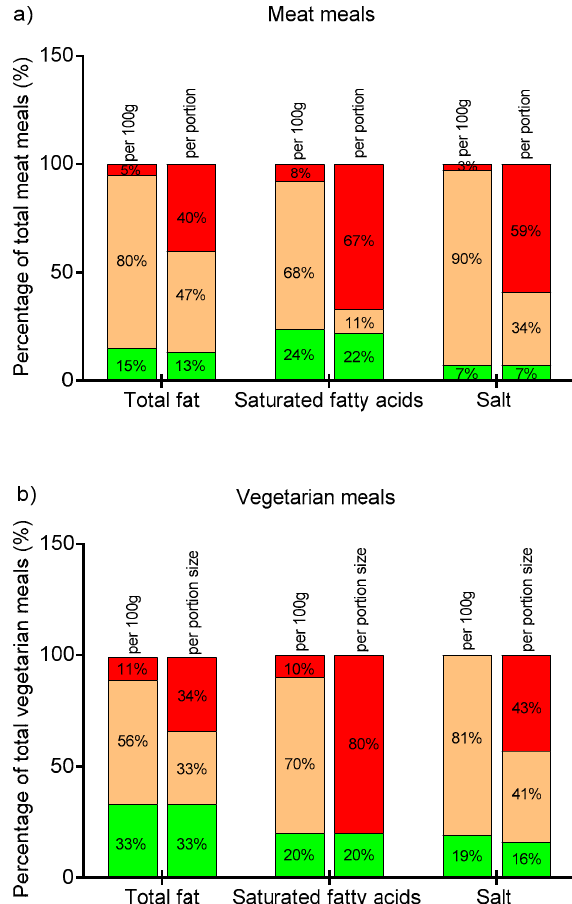
Figure 1. Traffic light distribution of meals per 100g and per portion based on the United Kingdom Food Standards Agency guidelines. ( a ) Meat category: total fat ( n = 73), saturated fatty acids (SFAs) ( n = 39), salt ( n = 73); ( b ) vegetarian category: total fat ( n = 39), SFAs ( n = 10), salt ( n = 39). Red indicates high, amber is medium, and green is low content of total fat, SFAs, and salt.